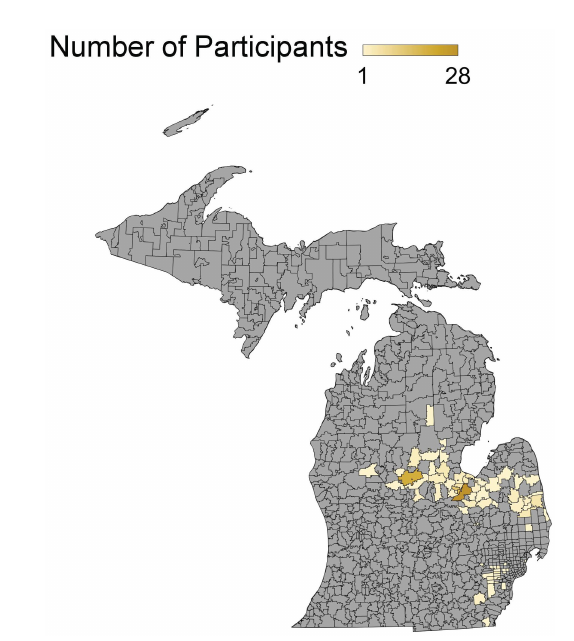
FIGURE 3 Participant population density map. Geographical areas represented among participant population.